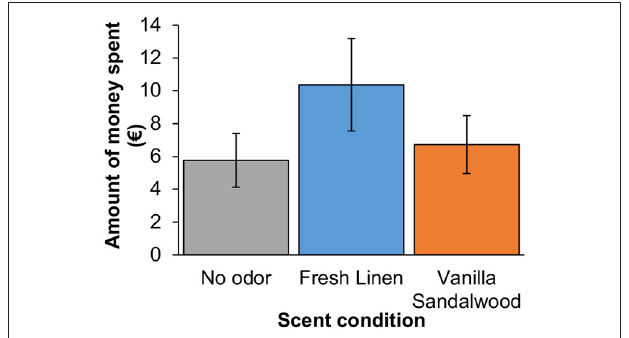
FIGURE 3 | Mean total amount of money spent by customers in second-hand store as a factor of